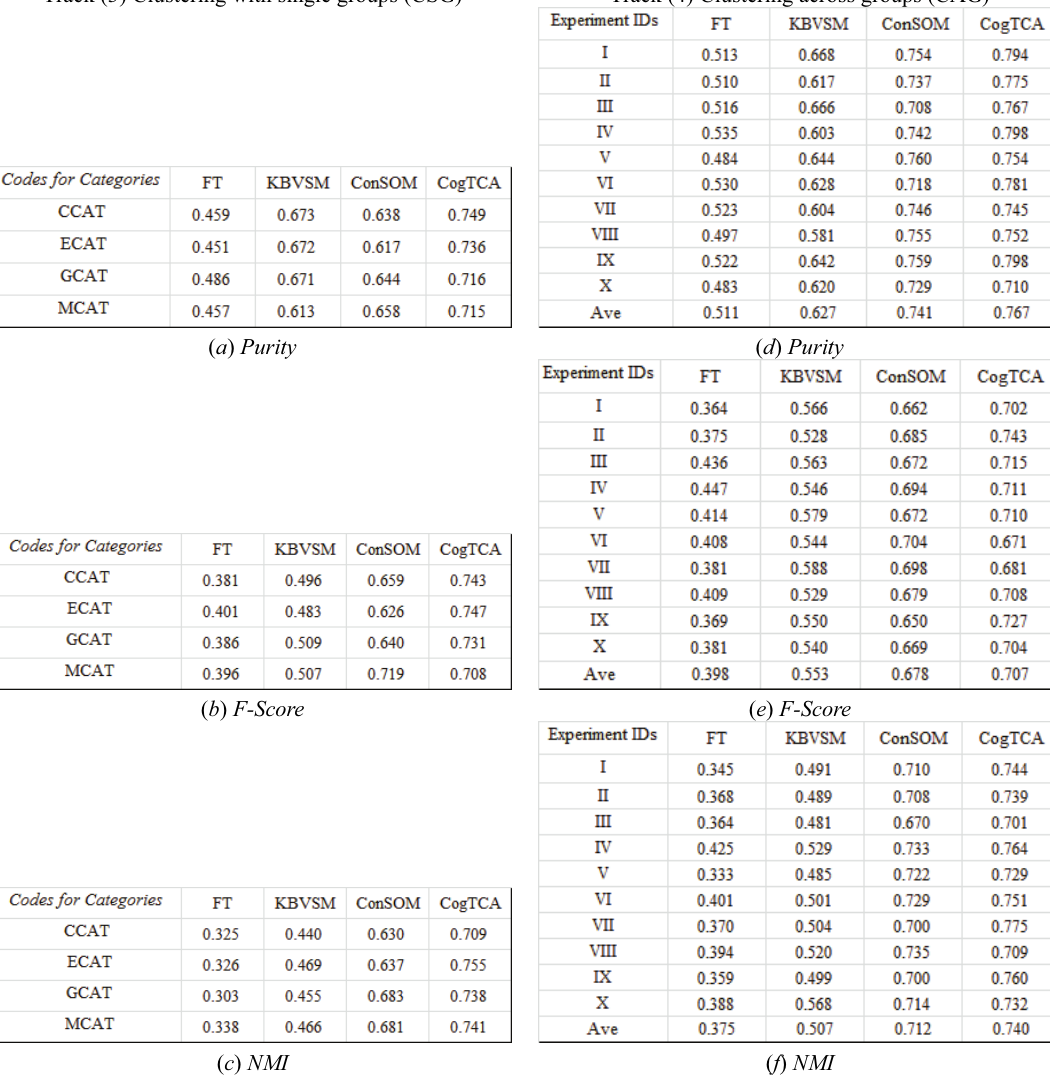
Fig.B.2 Experimental results of CSG and